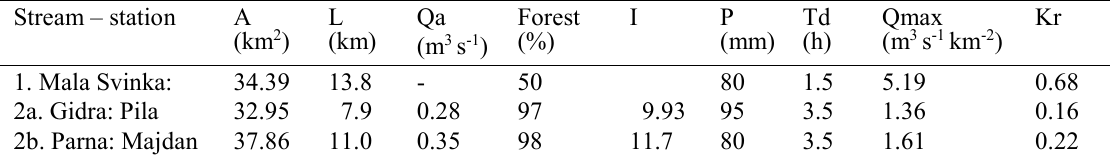
Table 1 Basic physico-geographic characteristics of the selected catchments: A – catchment area, L – length of the valley, Qa – mean annual discharge, I – slope, P – rainfall depth during the flood, Td – rainfall duration during the flood, Qmax – peak specific yield during the flood, Kr – runoff coefficient of the flood wave. Stream – station A Qa L Forest (km 2 ) (km) (%) (m 3 s -1 )